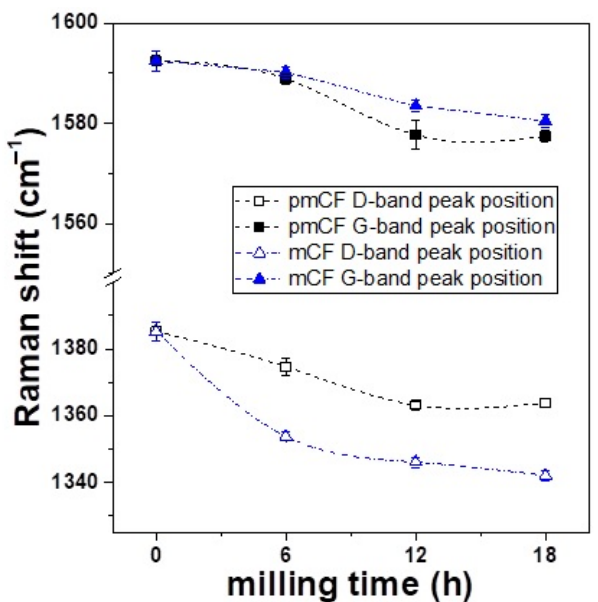
Figure 5. Peak position change of the first-order D and G bands.